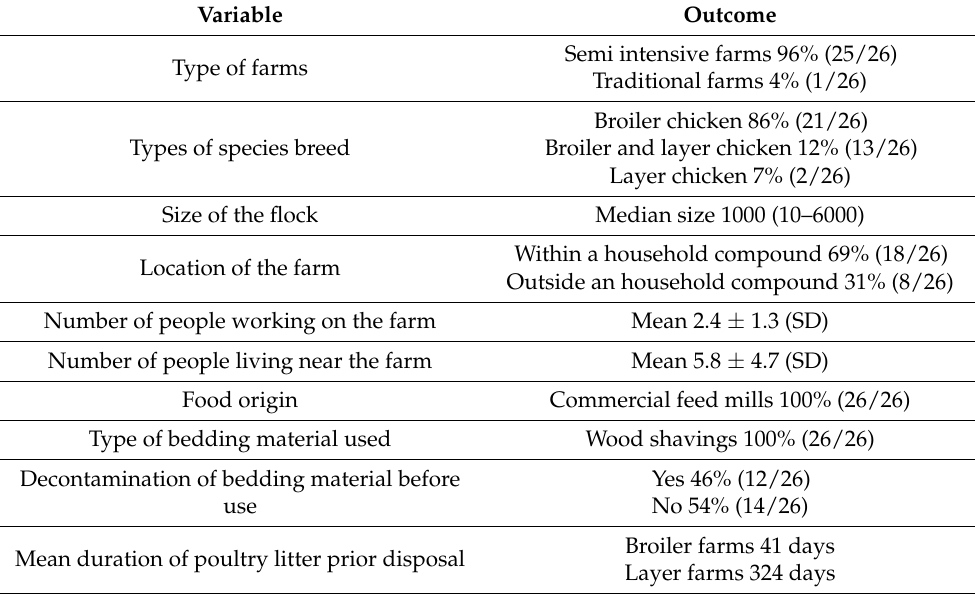
Table 1. General characteristics of